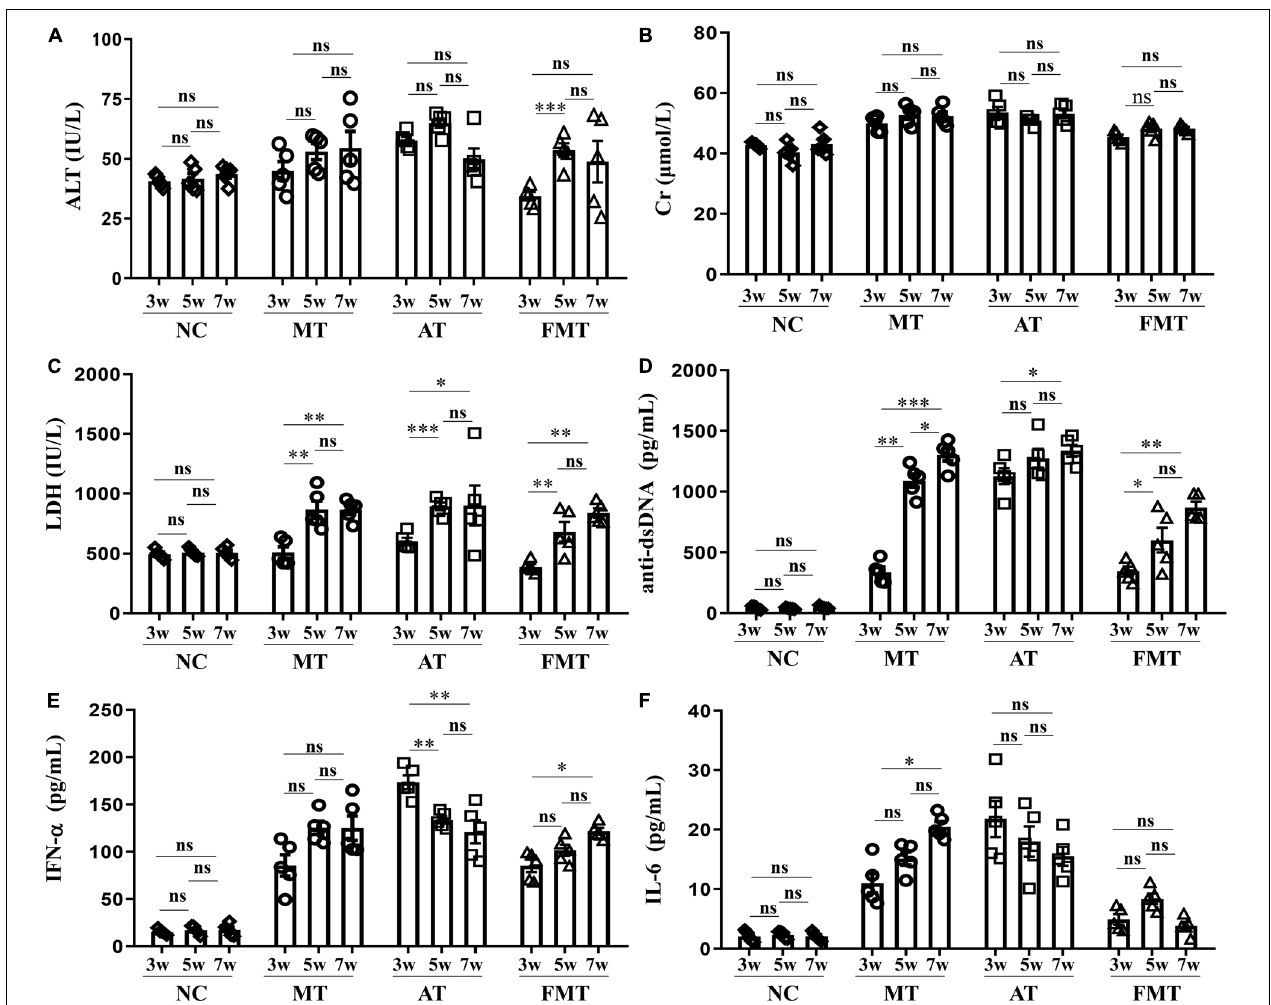
FIGURE 3 | Dynamics of serum alanine aminotransferase activity (A) , creatinine (B) , lactate dehydrogenase activity (C) , anti-double stranded DNA antibody (D) , interferon- α (E) and interleukin-6 (F) from 9 to 13 weeks old in MRL/lpr mice from three groups. NC, The C57/BL6 mice treated with PBS solution from 6 to 9 weeks old; MT, the MRL/lpr mice treated with PBS solution from 6 to 9 weeks old; AT: the MRL/lpr mice treated with antibiotics from 6 to 8 weeks old and PBS solution from 8to 9 weeks old; FMT, the MRL/lpr mice treated with antibiotics from 6 to 8 weeks old and fecal microbiota transplantation from 8 to 9 weeks old. “ ∗∗∗ ”represents p < 0.001; “ ∗∗ ” represents p < 0.01; “ ∗ ” represents p < 0.05; “ns” represents no significant difference. N =